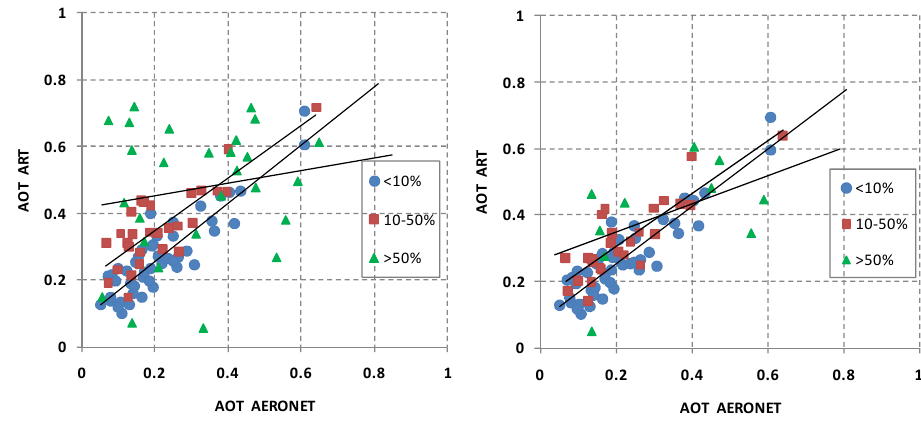
Fig. 24. The satellite-derived AOT values at λ = 440nm for the region of Belsk (Poland) versus AERONET AOT. Different signs are given for cloud situations with numbers of pixels identified as cloudy less than 10%, in the range of 10–50%, and more than 50% (see the legends). The lines show the linear regressions between the retrieved AOT values and AERONET data. MERIS data are averaged over a circle with the radius of 20km with the centre in the pixel where AERONET measurements were performed (left picture). The same but with the additional discarding of pixels in the square 5 × 5 pixels with a cloudy pixel in the centre (right picture).